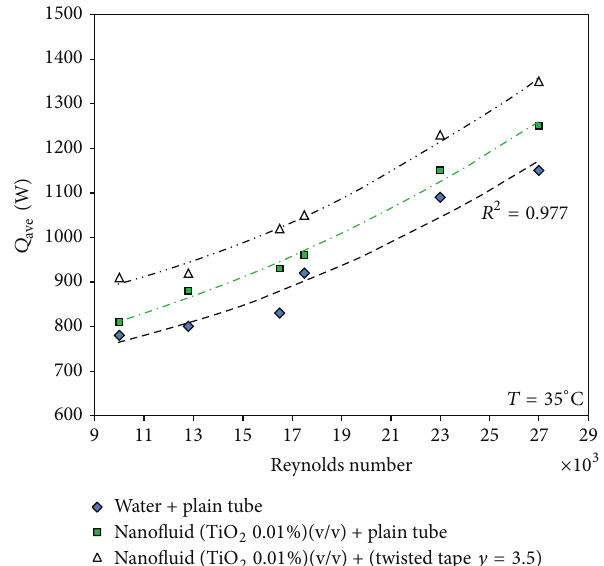
Figure 5: Variation of mean heat flow rate with Reynolds number.